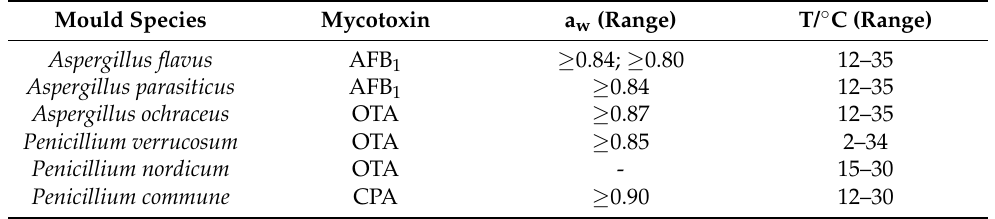
Table 1. Conditions under which certain moulds produce mycotoxins on the surface of dry-cured meat products